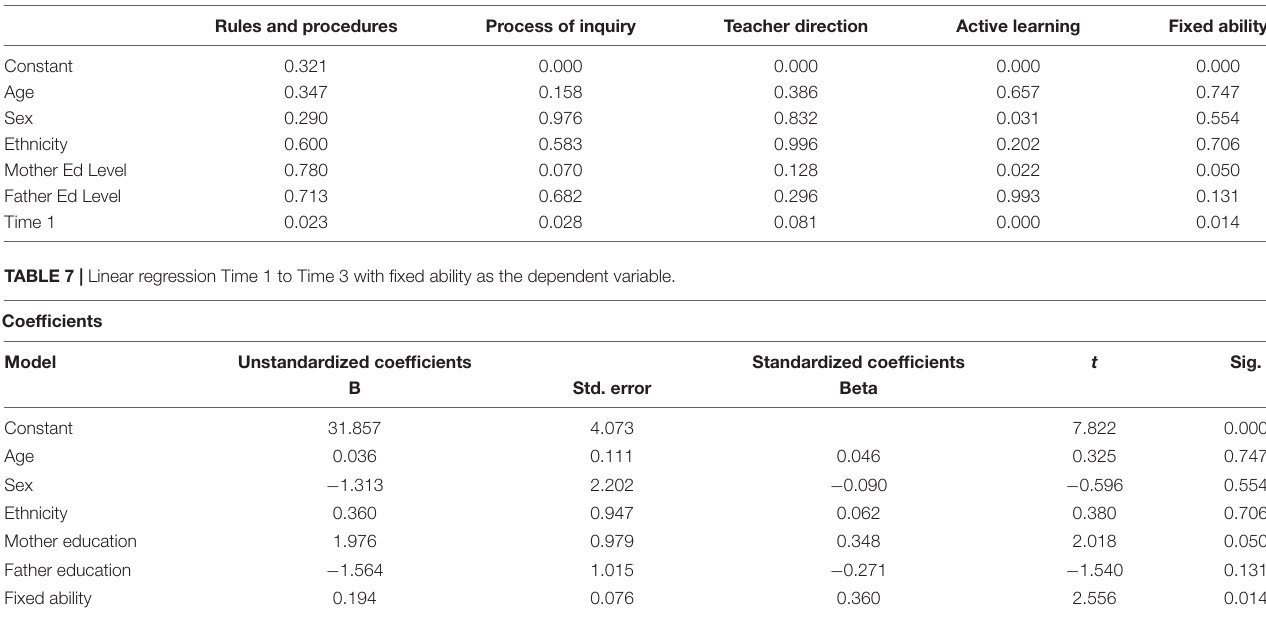
TABLE 6 | Summary of p values for linear regressions by survey category from Time 1 to Time 3 with Time 3 as the dependent variable.